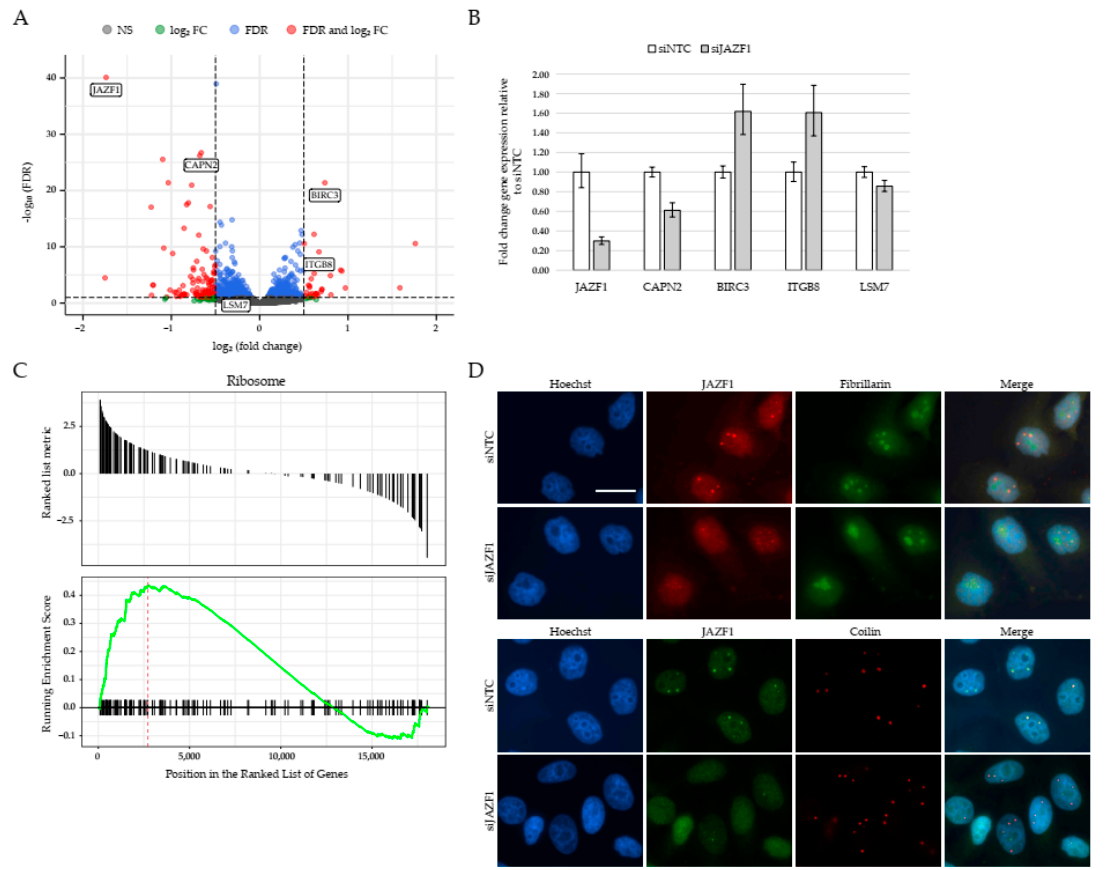
Figure 3. JAZF1 depletion leads to deregulation of genes involved in ribosome biogenesis. ( A ) Volcano-plot representation of differential expression analysis of genes upon JAZF1 depletion (siJAZF1 vs. siNTC), showing 162 statistically significant deregulated genes, 130 downregulated and 32 upregulated. Red dots represent statistically significant deregulated genes (log2FC > 0.5 or < − 0.5 and False Discovery Rate (FDR) < 0.1); blue dots represent genes with significant statistical values (FDR < 0.1) that not reach our fold change threshold; green dots represent genes with significant expression changes (log2FC > 0.5 or < − 0.5) without providing enough statistical evidence; gray dots represent genes with no statistical or fold-change significance. Genes that were validated by using RT-qPCR ( B ) are highlighted with boxes. See also Supplementary Materials Figure S1B for PCA plot of deregulated genes upon JAZF1 knockdown. ( B ) RT-qPCR verification of two downregulated (JAZF1 and CAPN2) and two upregulated (BIRC3 and ITGB8) genes and one in its expression unchanged gene (LSM7) upon JAZF1 depletion. Shown is the fold change of three replicates normalized to HPRT1 expression. Error bars depict the SD of three replicates. Shown is one out of three biological replicates showing similar results. ( C ) Gene set enrichment analysis (GSEA) plot showing statistically significant and consistent differences of genes associated with the KEGG (Kyoto Encyclopedia of Genes and Genomes) pathway “Ribosome” upon JAFZ1 depletion. See also Supplementary Materials Figure S1C,D for further GSEA analyses. ( D ) Immunofluorescence microscopy analysis of HeLa Kyoto cells co-stained with antibodies against JAZF1 (top, red; bottom, green), Fibrillarin (green, top) or Coilin (red, bottom) and Hoechst (DNA, blue) after control (siNTC) or JAZF1 (siJAZF1) knockdowns. Scale bar for all pictures = 20 µm. Gene set enrichment analysis (GSEA) based on the differential expression (siJAZF1 vs. siNTC) of all genes revealed a statistically significant enrichment of factors involved in ribosome biogenesis, among other pathways (Figure 3C and Supplementary Materials Figure S1C,D). This observation is in line with the finding that JAZF1 localizes not only to the nucleus, but also that observed bright JAZF1 speckles overlap with some nucleoli, as